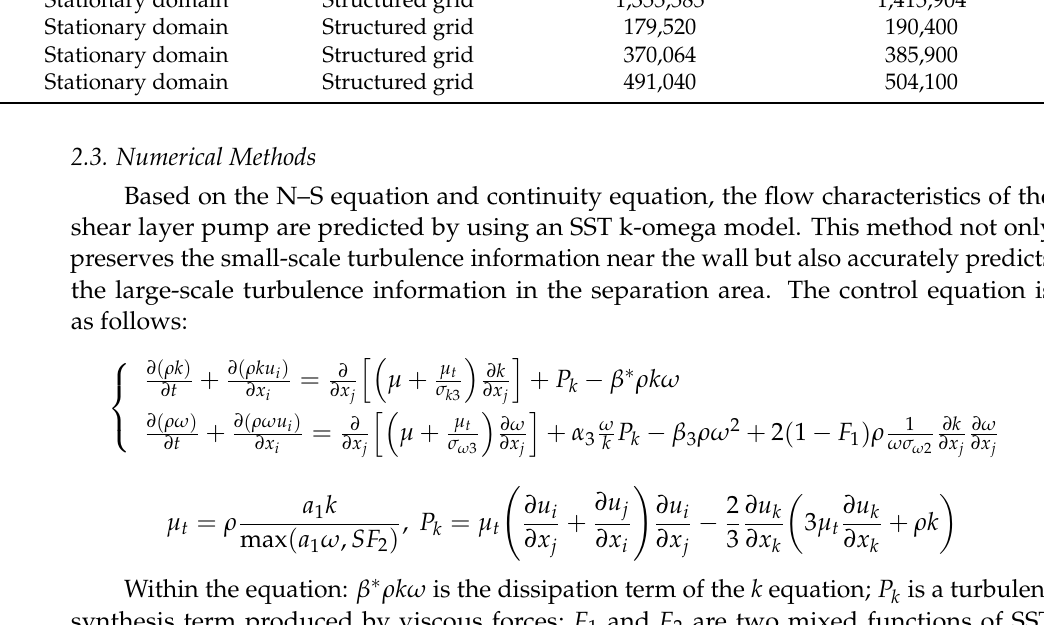
Table 2. Local grid size.